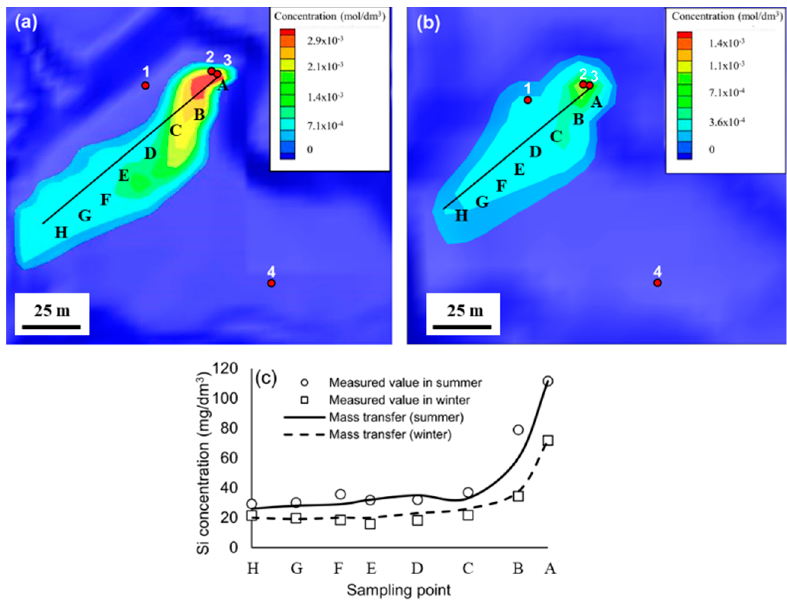
Figure 6. Simulation result: Distribution map of Si concentrations ( a ) in summer and ( b ) in winter, and ( c ) measured Si concentrations on lines A–H and the fitting results.